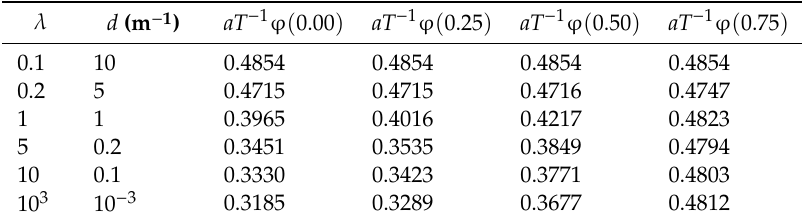
Table 4. Relative stresses aT − 1 ϕ ( x ) at di ff erent values of the coordinate x .